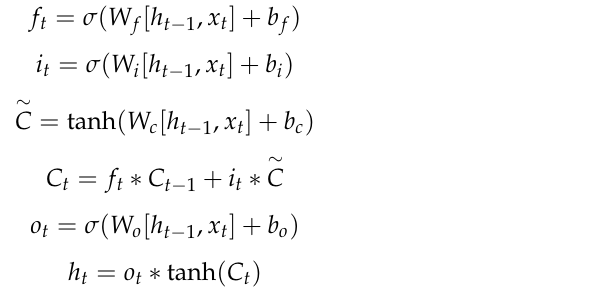
Figure 3. Diagram of the LSTM network.